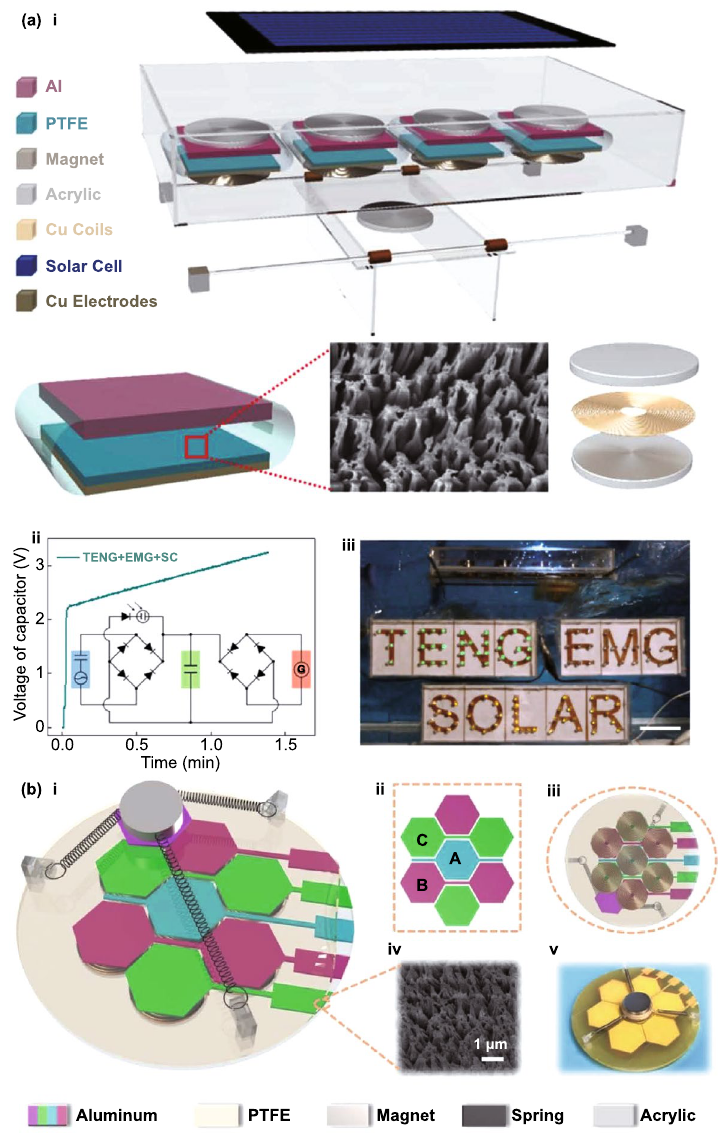
Fig. 22 a (i) Structure design of the multifunctional hybrid power unit for harvesting blue energy fabricated by Shao et al., composed of four repeated contact-separation TENGs, corresponding free-standing sliding-mode EMGs and a waterproof silicon-based solar cell. (ii) Measured voltages of a 33 μF commercial capacitor charged by the hybrid power unit. (iii) Demonstrations of the hybrid power unit as a practical power source. Reproduced with permission from Ref. [95]. Copyright 2017, Elsevier Ltd. All rights reserved. b Structural design of the hybridized ocean wave nanogenerator developed by Feng et al. (i) Schematic diagram. (ii) Structure of the electrodes of the TENG units. (iii) Copper coils of the EMG units in the bottom. (iv) SEM image of the PTFE surfaces. (v) Photograph of the nanogenerator. Reproduced with permission from Ref. [96]. Copyright 2018, Elsevier Ltd. All rights reserved. (Color figure